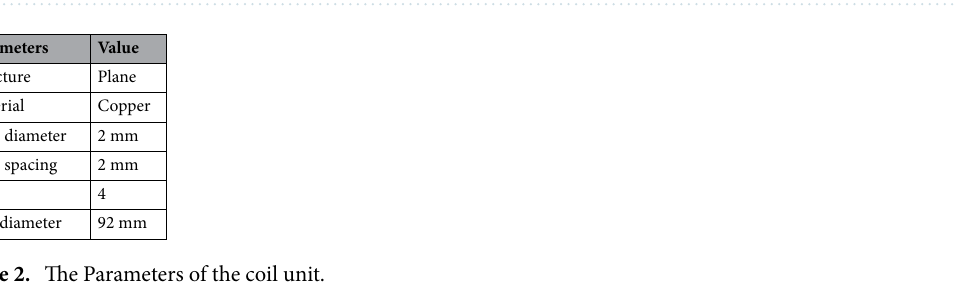
Figure 8. ( a ) The magnetic field distribution of the system without the metamaterial, ( b ) The magnetic field distribution of the system with the metamaterial.